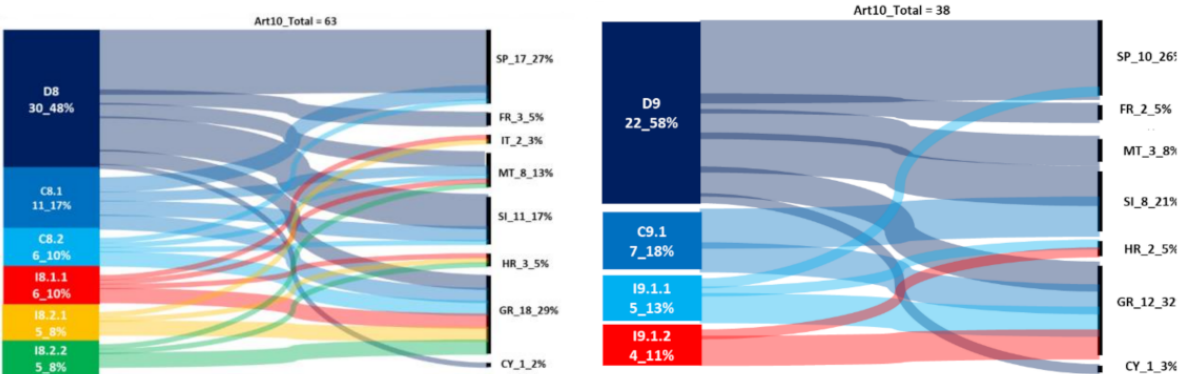
Figure 10. Interrelation of established environmental targets and associated indicators with Com Dec 2010/477/EU criteria and indicators for Contaminants Descriptors (IT did not establish targets for D9) in